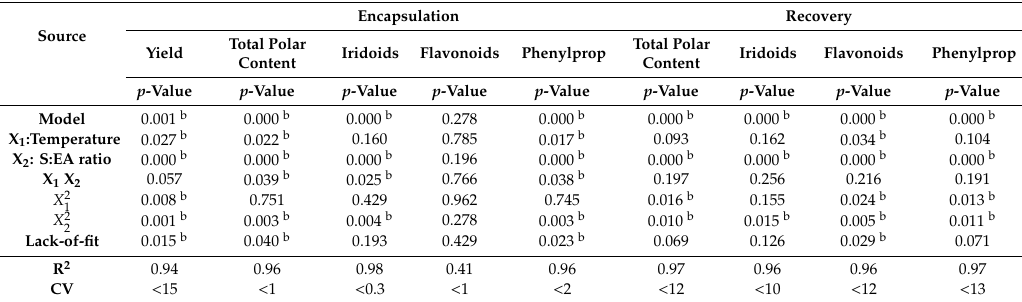
Table 2. Analysis of variance (ANOVA) of the regression models. Response variables: Yield, encapsulation and recovery of total polar content and both chemical group in Maltodextrin microparticles.